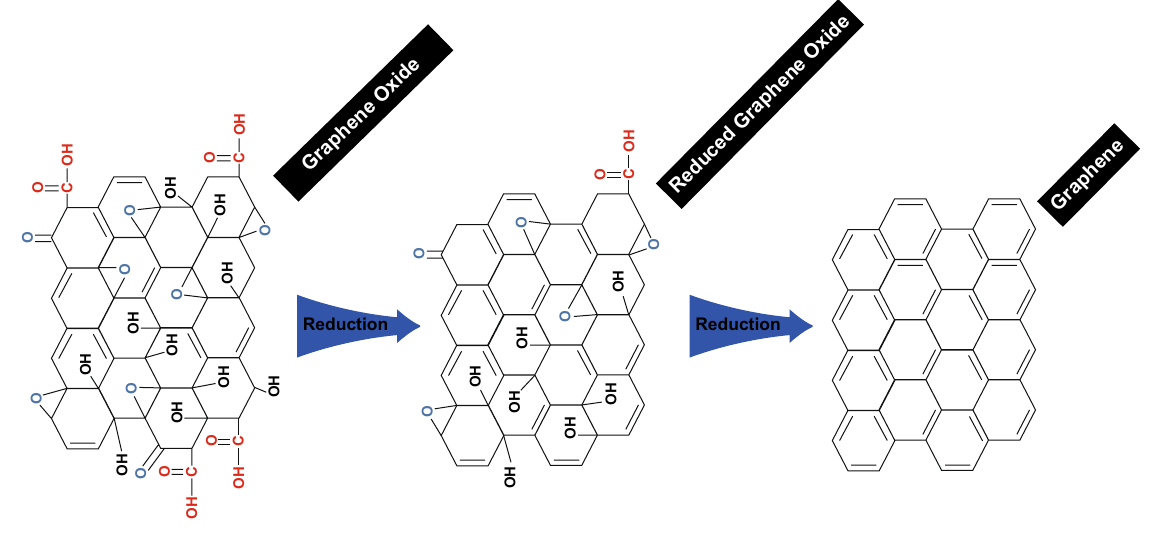
Fig. 1 Comparing graphene oxide, reduced graphene, and highly reduced (cleared)